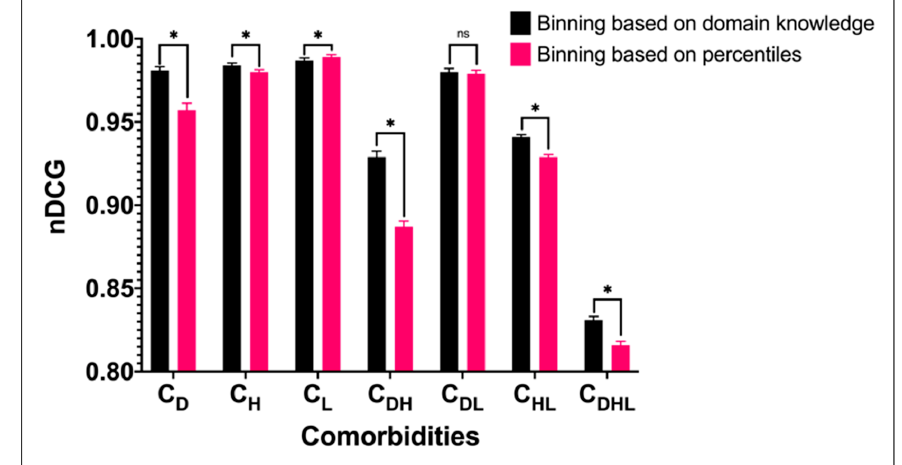
Figure 3. Effect of binning strategies on nDCG@10 . * indicates statistically significant based on paired t -test, while ns indicates not statistically significant.